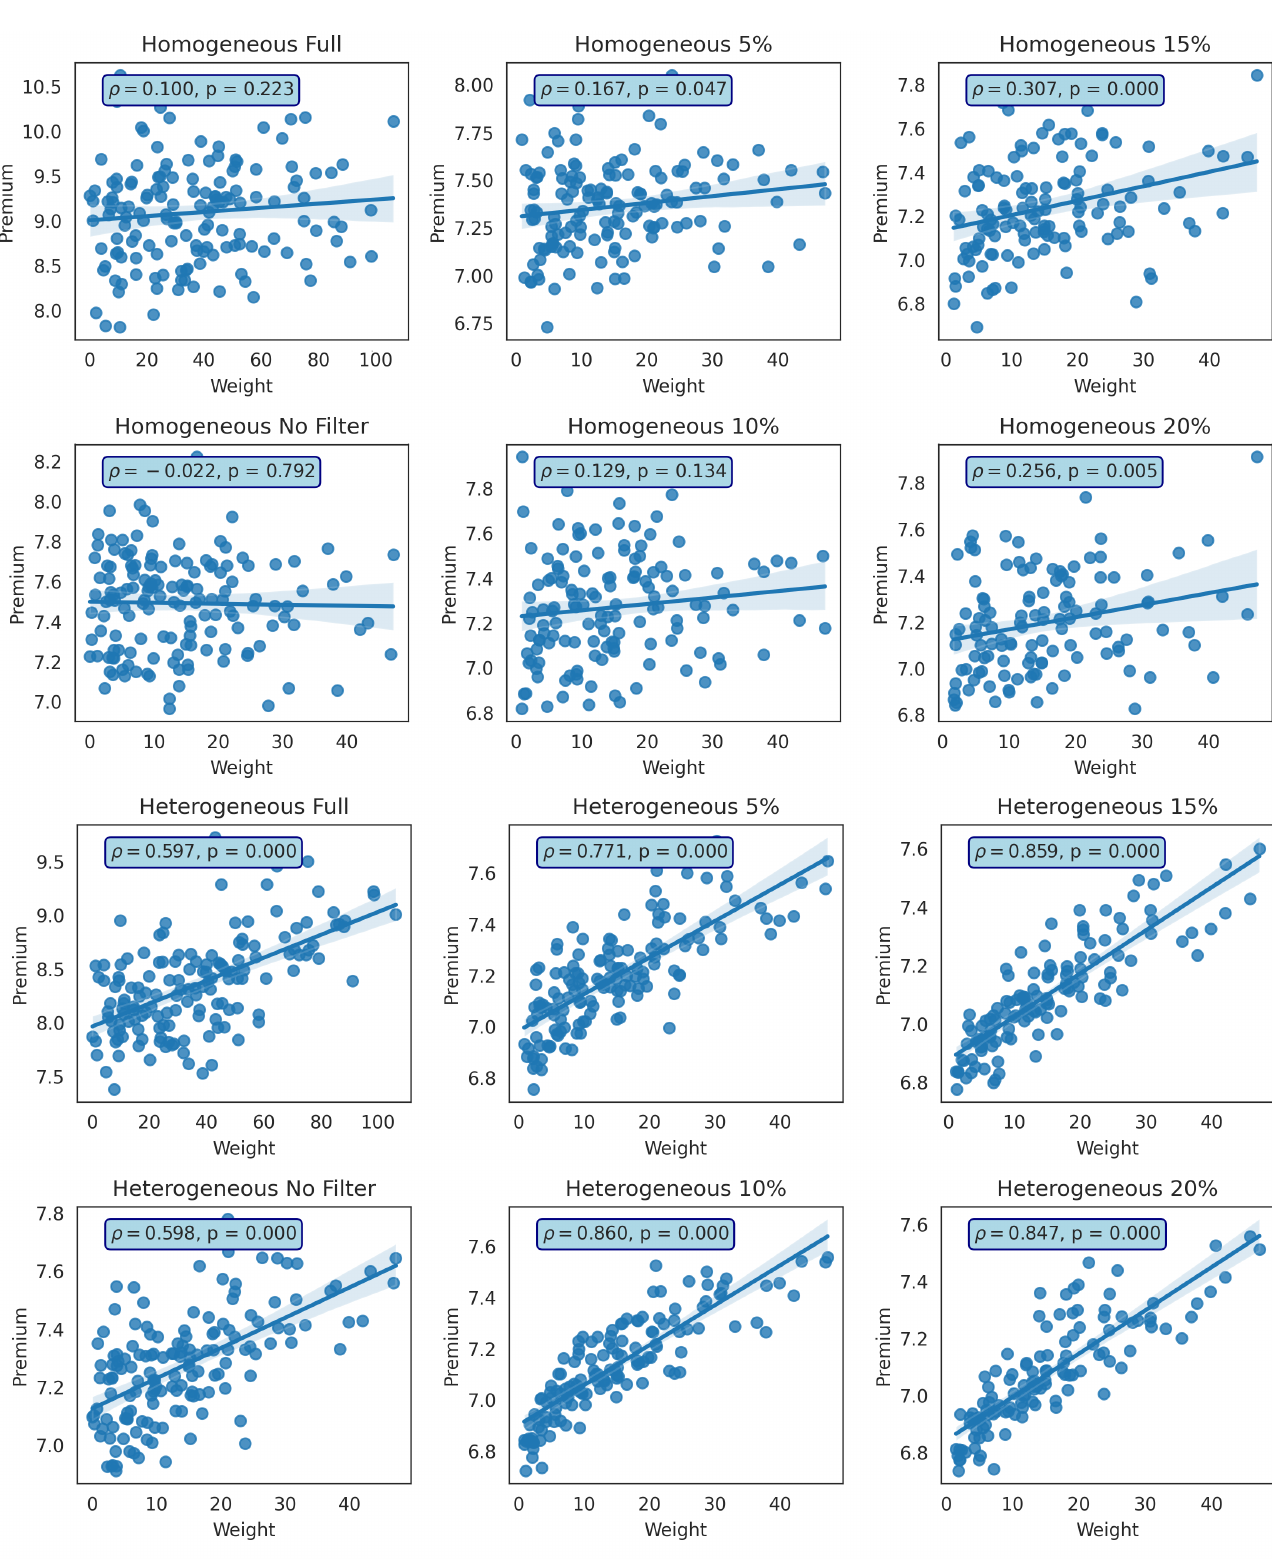
Figure 18. Relationship between the total weight of neighbors and their premium (homogeneous and heterogeneous) for two cases: (1) without GMA (Full), and (2) with GMA (using filter 0% (No Filter), 5%, 10%, 15%, and 20% in the second network. ρ is the Pearson correlation coefficient and p is the probability